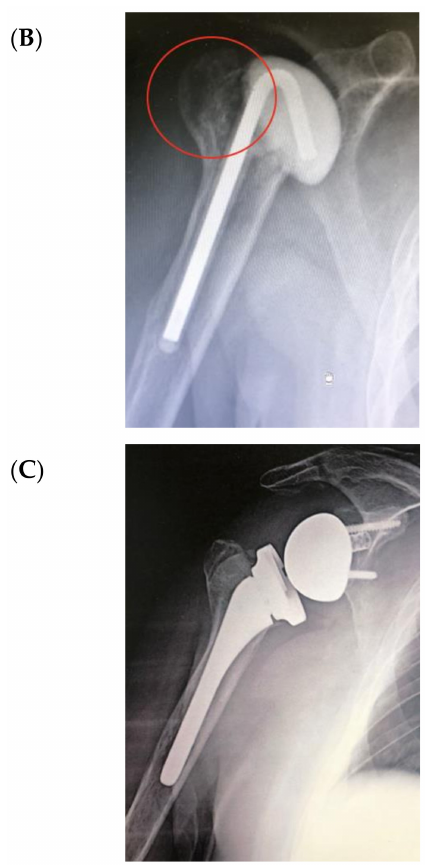
Figure 2. An infection after percutaneous pinning of a proximal humerus fracture. ( A ) Preoperative X-ray. ( B ) The subsequent implanting of a cement antibiotic spacer (red circle underlines bone loss); ( C ) the final reverse arthroplasty (RSA) with the addition of bioactive glass in the tuberosity